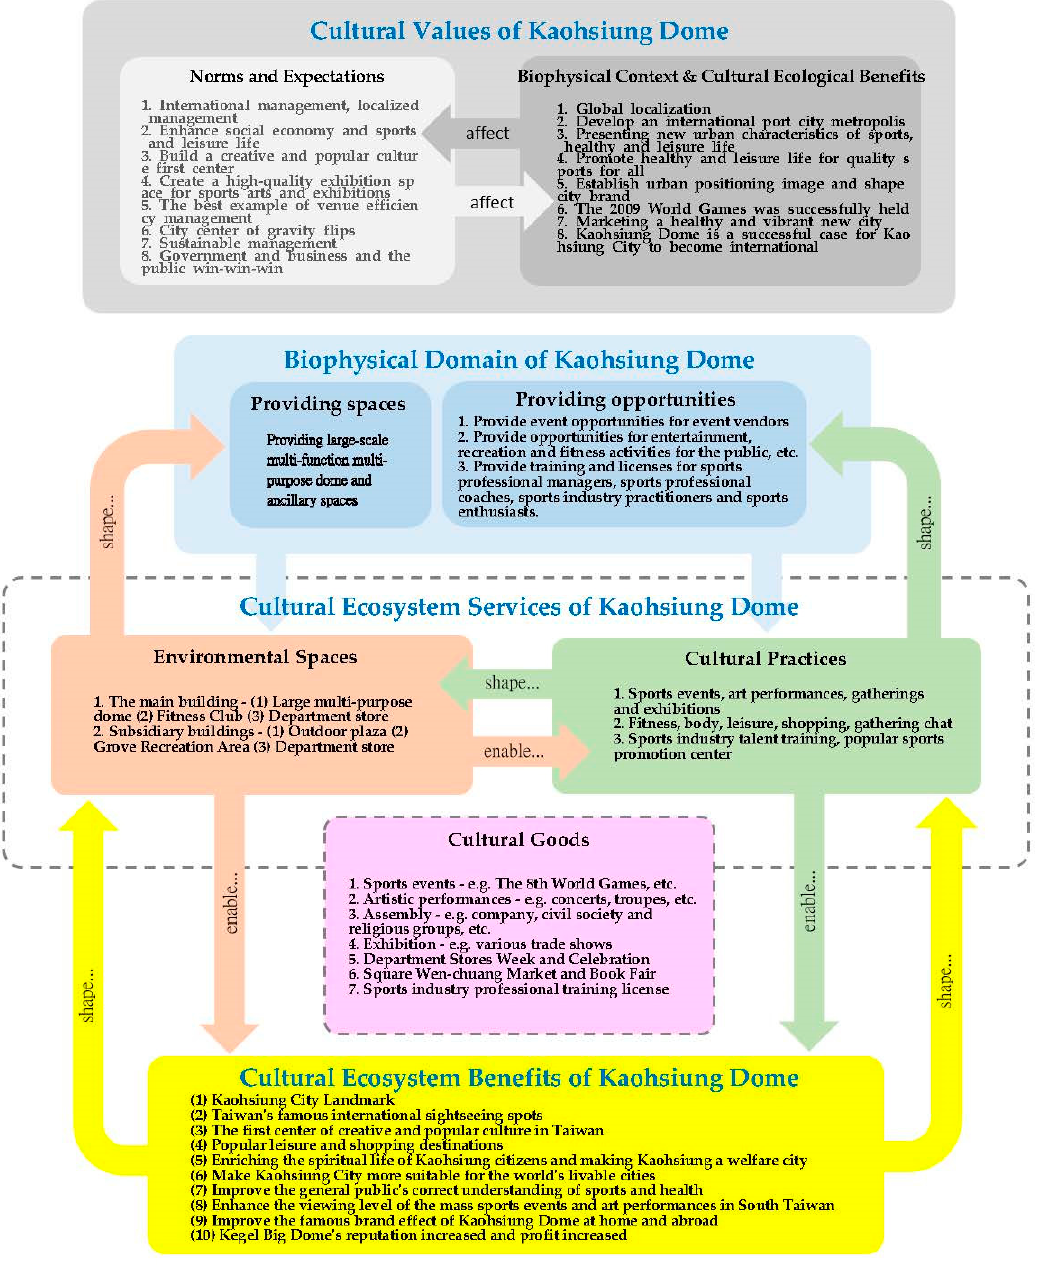
Figure 12. The Cultural Ecosystem Service Innovation Framework of Kaohsiung Dome.